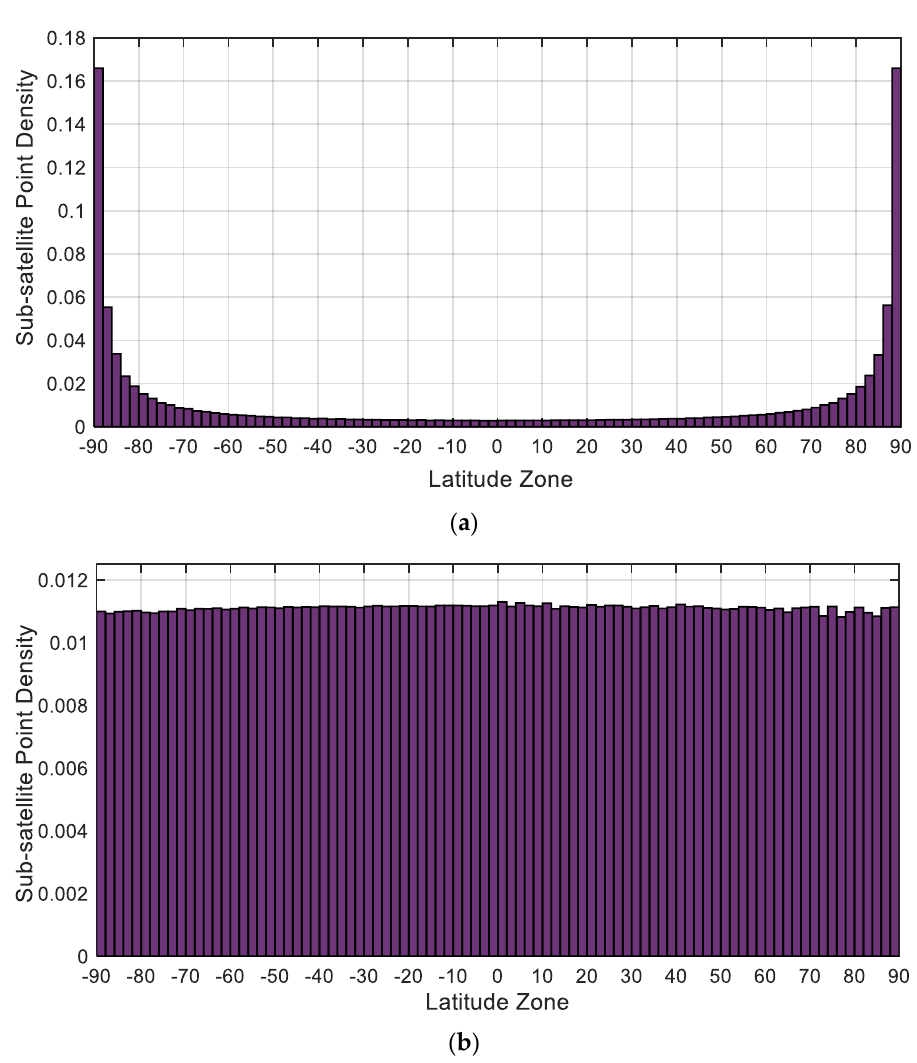
Figure 8. Comparison of the distribution of sub-satellite points density along latitude zones in the mixed Walker constellation and Walker constellation. ( a ) Distribution of sub-satellite points density along latitude zones of a Walker constellation with 5625 satellites; ( b ) Distribution of sub-satellite points density along latitude zones of a mixed Walker constellation with 5686 satellites.